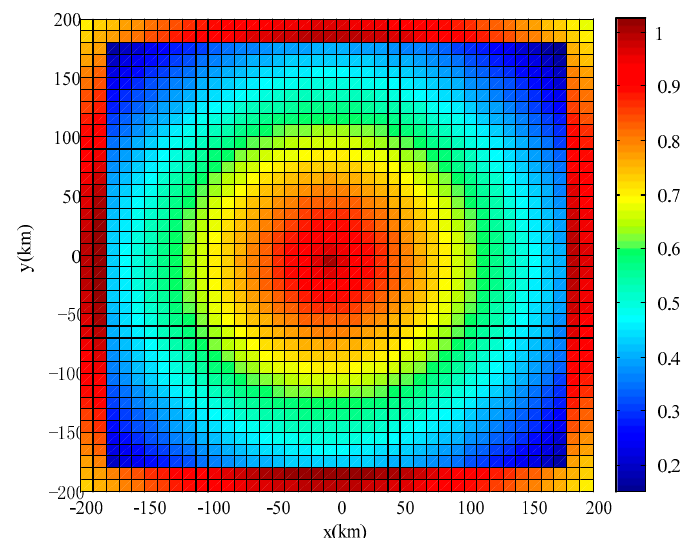
Figure 2. The distribution of the monitoring priority in domain Ω 0 .